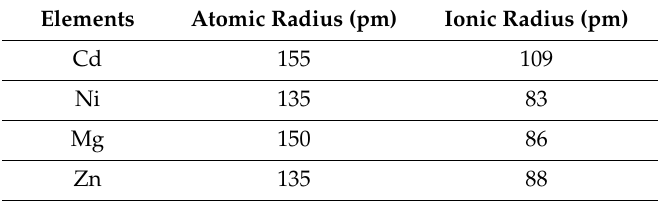
Table 1. Atomic radius and ionic radius of various elements utilized.